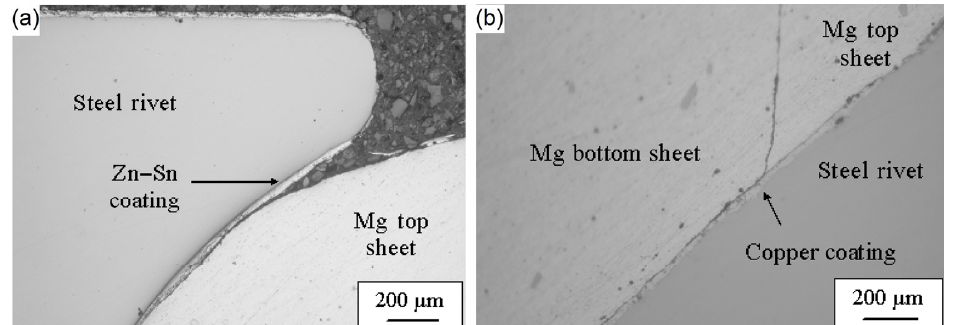
Fig. 19 Cross section images of mechanically plated Zn ‒ Sn rivet in a Mg joint (a) at the end of the rivet head in the top sheet, and (b) along the rivet shank near both top and bottom sheets. Reproduced with permission from Ref. [61], © Trans Tech Publications Ltd,